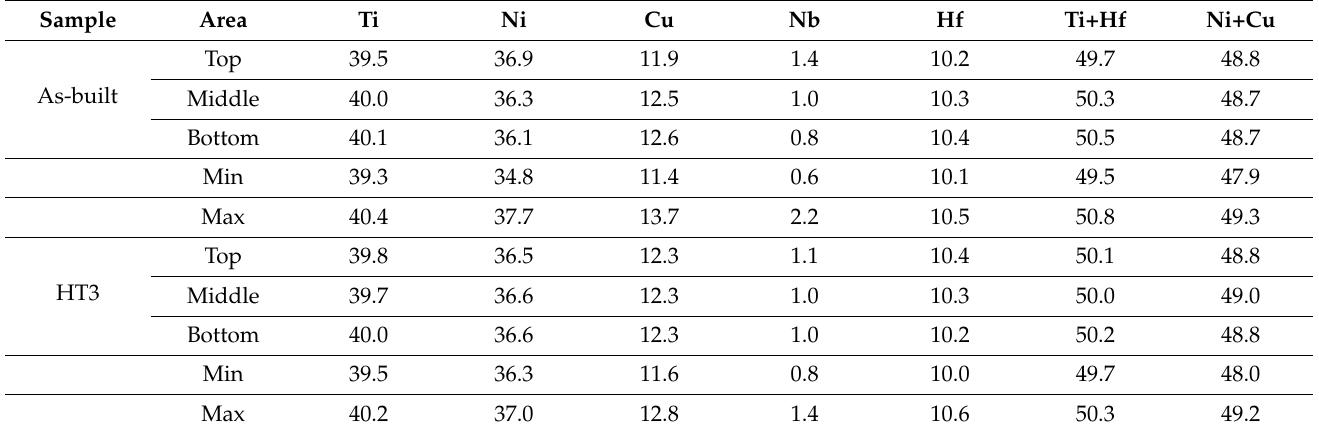
Table 3. Table of average matrix composition calculated from EDS mapping of As-fabricated and